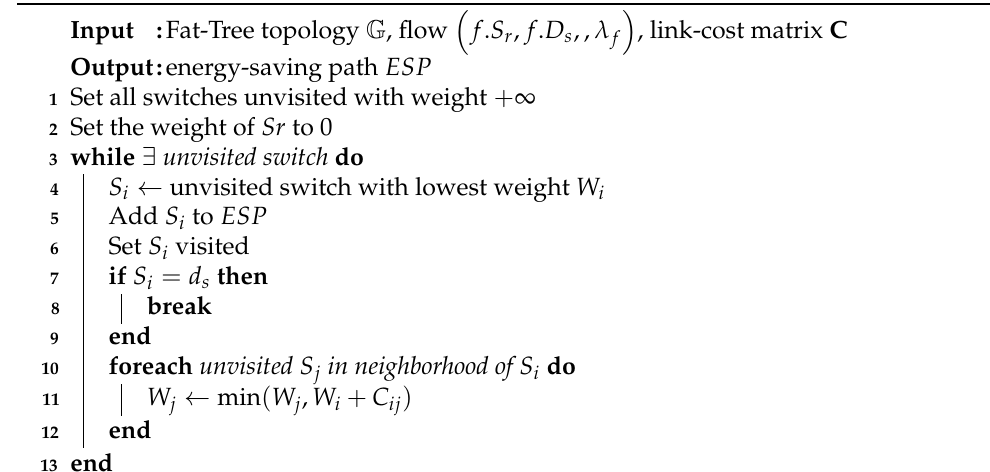
Algorithm 3: Fill-Shortest Path (Dijkstra-like algorithm).